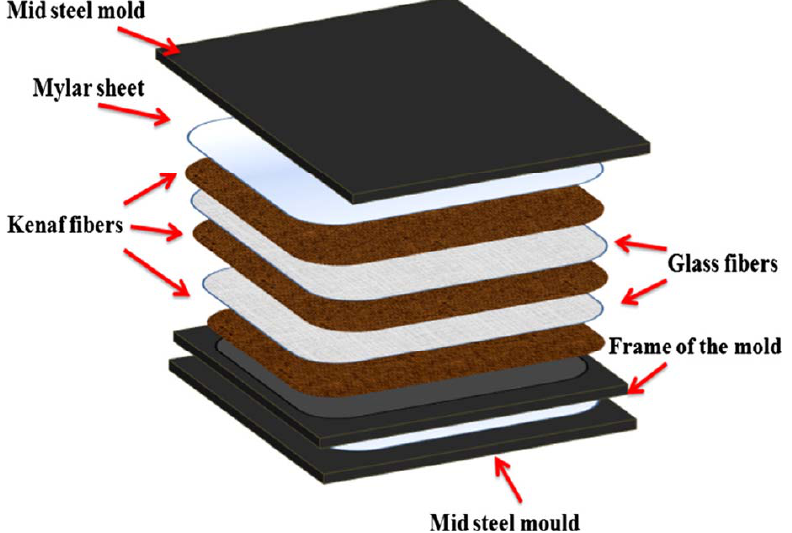
Figure 4. The sequence of kenaf and glass fibers and matrix in between mold for hybridization conducted by Atiqah et al. [48]. Extracted with permission from